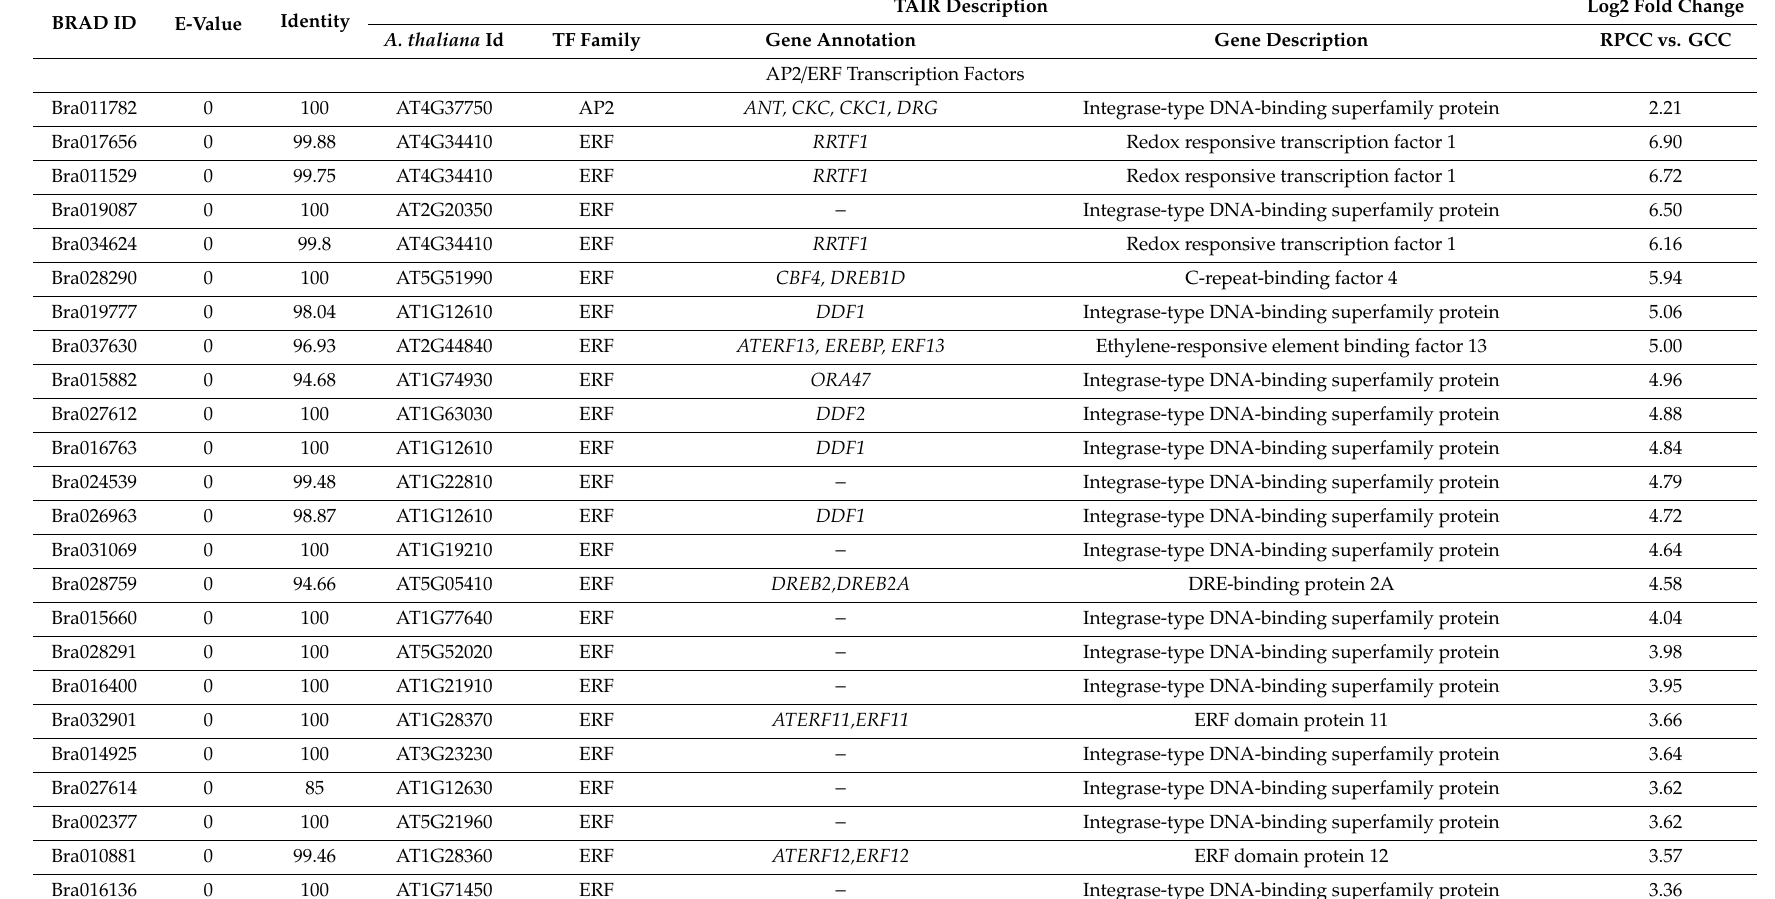
Table 3. Summary of important regulatory transcriptional factor family genes identified from transcriptome